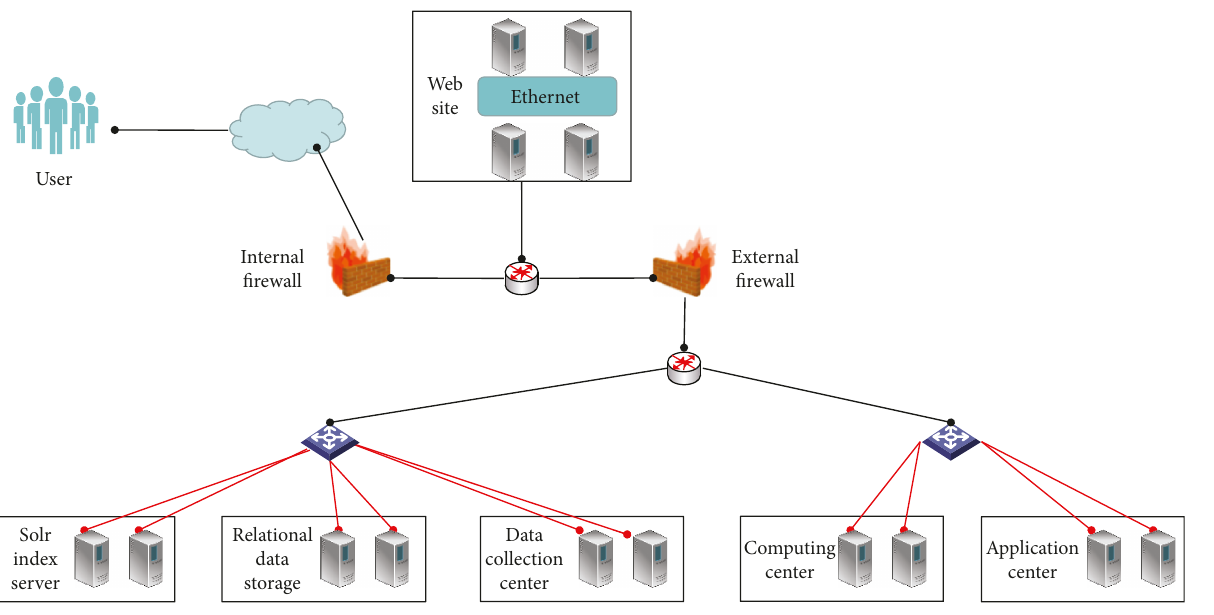
Figure 1: System network